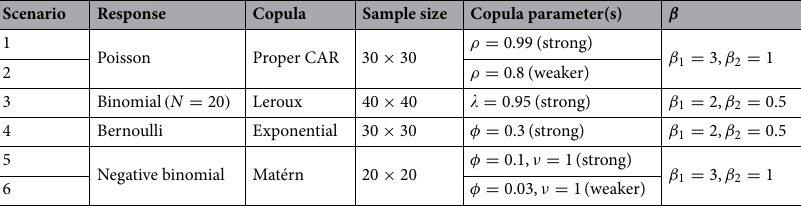
Table 1. Scenarios for the simulation study.